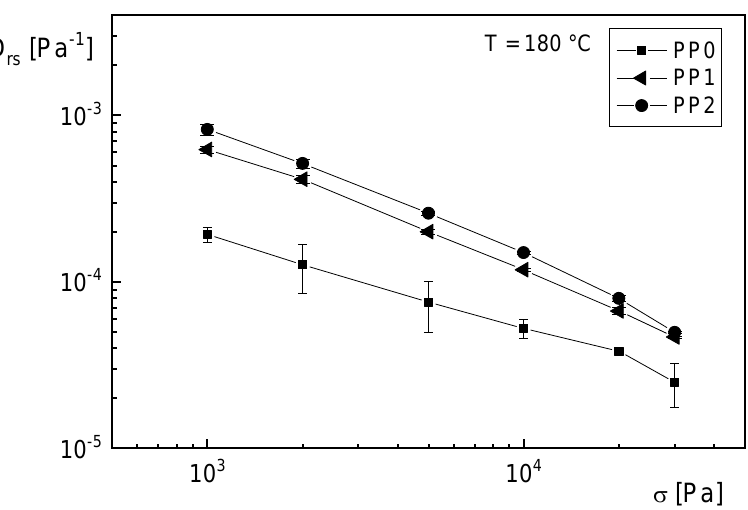
Figure 6. Steady-state recoverable compliance D rs as function of tensile stress σ for the linear commercial polypropylene PP0 and samples electron beam irradiated with 1 kGy (PP1) and 2 kGy (PP2) [9].